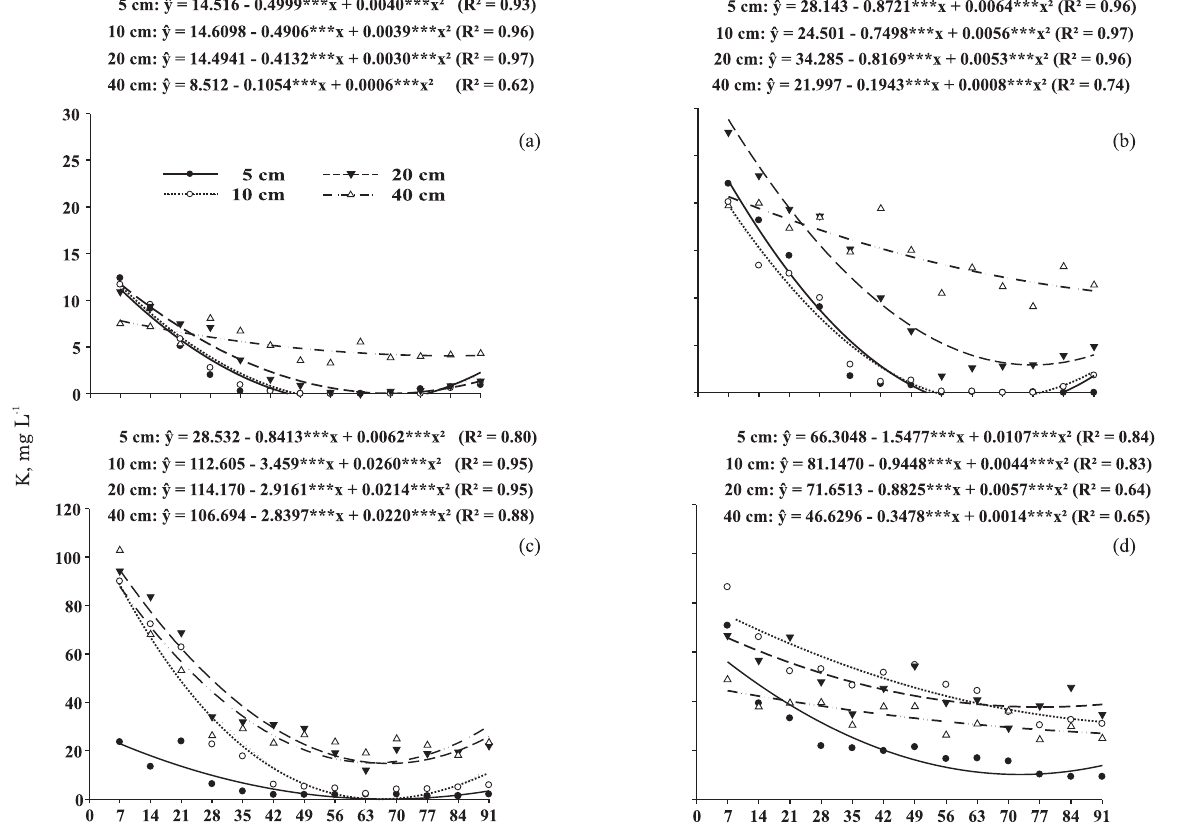
respectively.Figure 3. Potassium concentration in the soil solution at different depths and salinity levels: Casamento (a) Cavalhada (b) Banhado (c) Sinval (d). *, **, ***: significant at 10, 5 and 1 %, by the F-test,